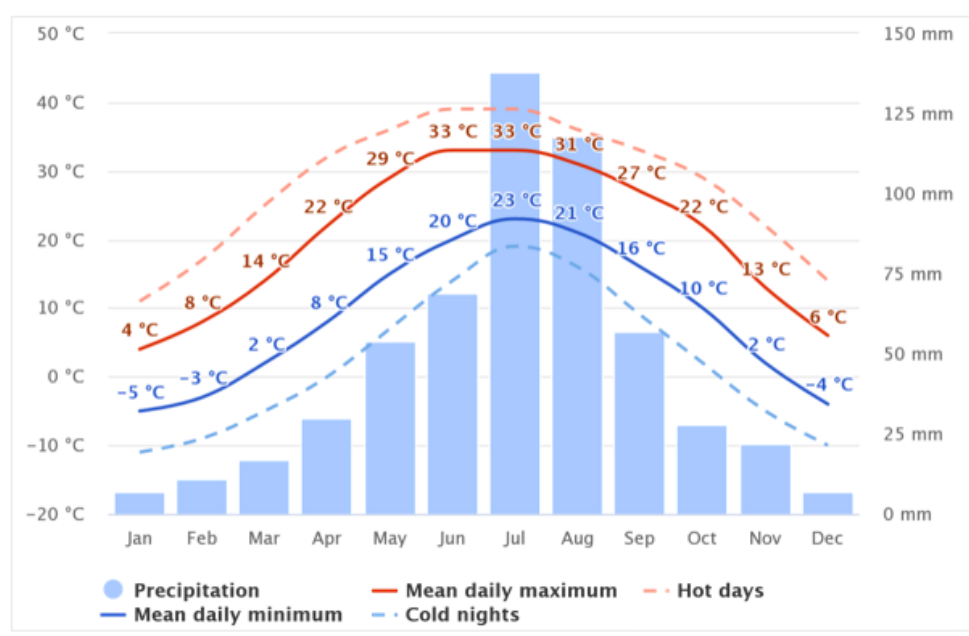
Figure 2. The monthly mean climatic data for Jinan city during a 30-year period obtained from Me- teoblue (2022) [58].